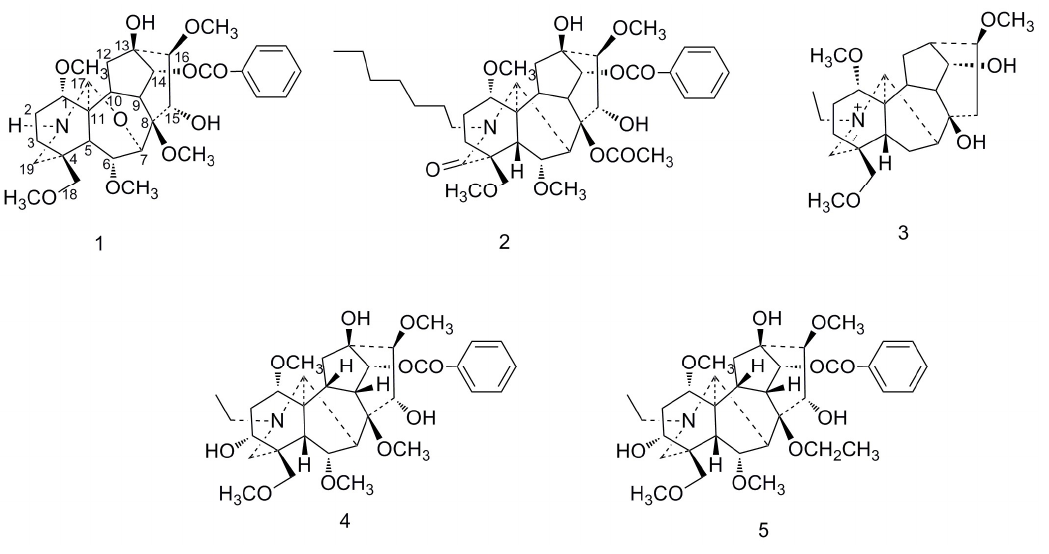
Figure 1. Structures of Compounds 1 – 5 .